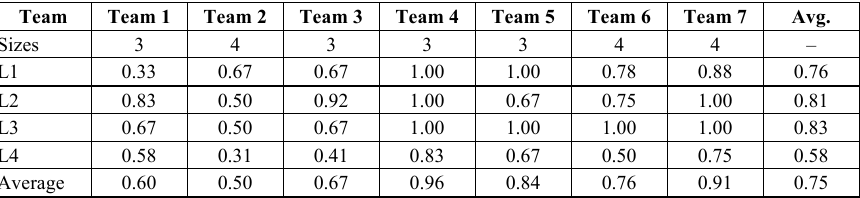
Table 2. Team participation in quizzes over the time-sorted lectures for C1.